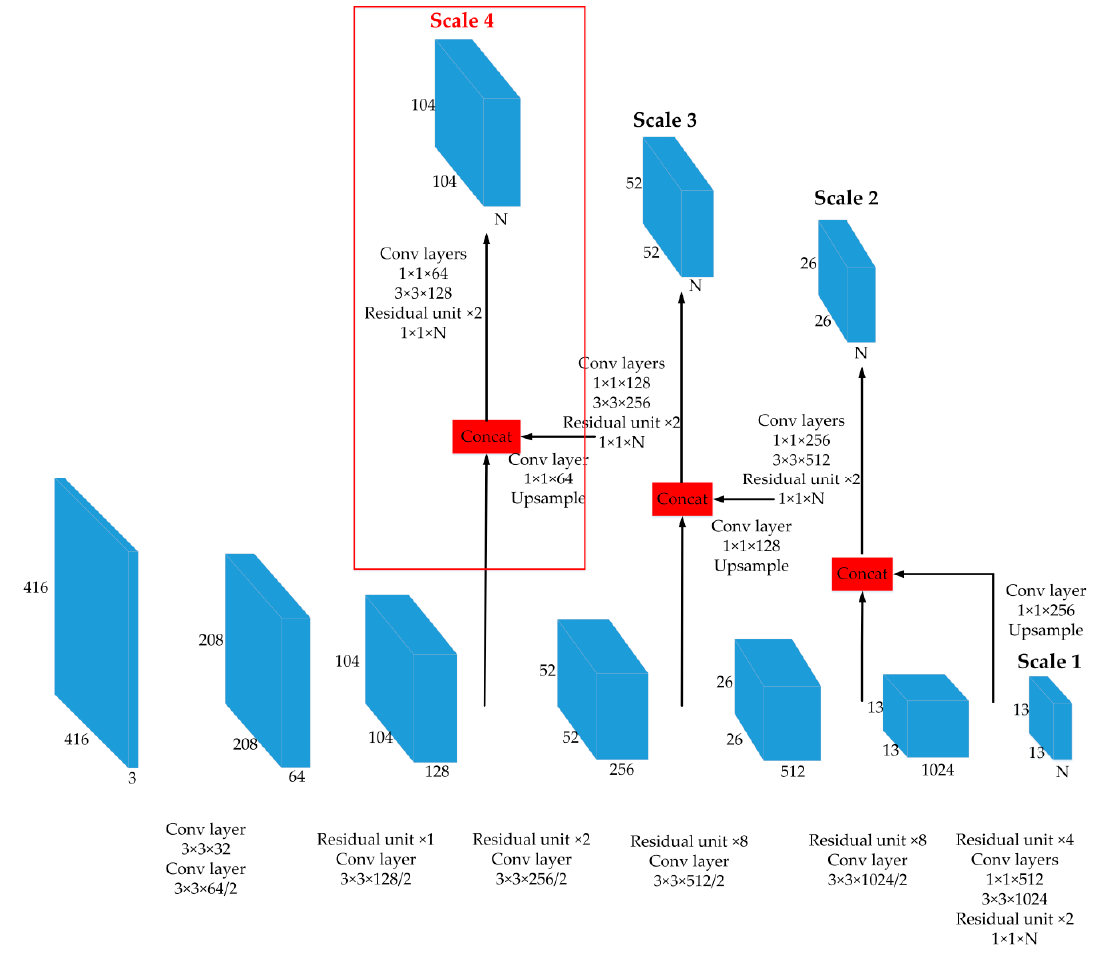
Figure 5. The network of improved YOLO V3.